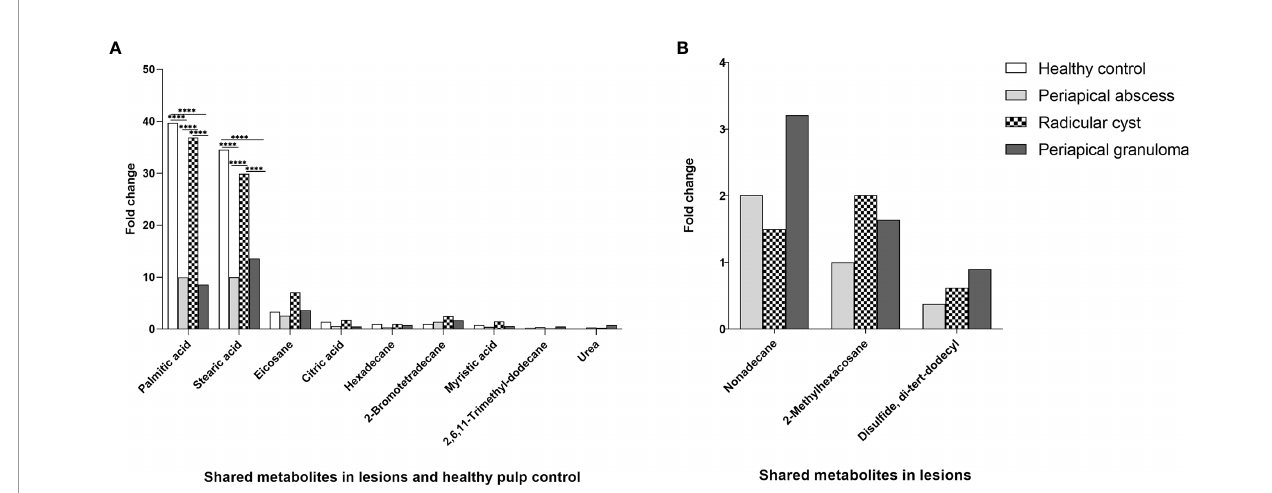
FIGURE 3 | Quantitative comparison of shared metabolites in periapical lesions and healthy control. The quantity of each metabolite was represented as the area under the peak of each metabolite in relation to the total areas of all other metabolites detected in an extract. The data displayed the fold change of area under the peak values of each metabolite in each group. The data were analyzed by two-way analysis of variance (ANOVA) using Tukey ’ s multiple comparisons test. P -value ≤ 0.05 was considered as signi fi cant. (A) Shared metabolites between periapical lesions and healthy control. Hexadecane in healthy control was regarded as one-fold and employed as a reference for the measurement of the other metabolites. (B) Shared metabolites between periapical lesions only. 2-Methylhexacosane in periapical abscess was used as a reference of one-fold for the measurement of metabolites in other lesions. **** reveals that P -value <